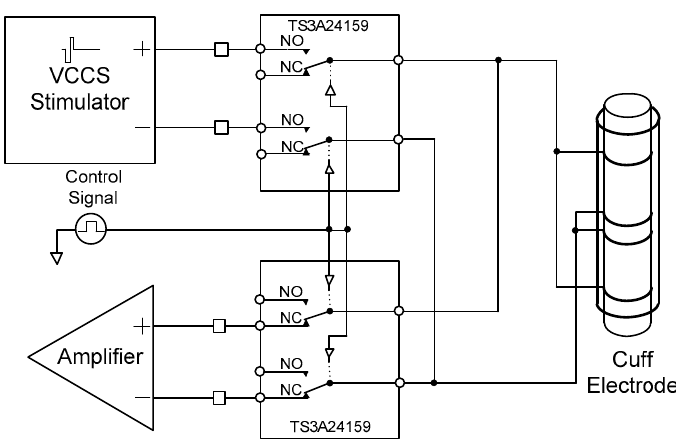
Figure 6. Block diagram of the proposed cuff-electrode path controller.